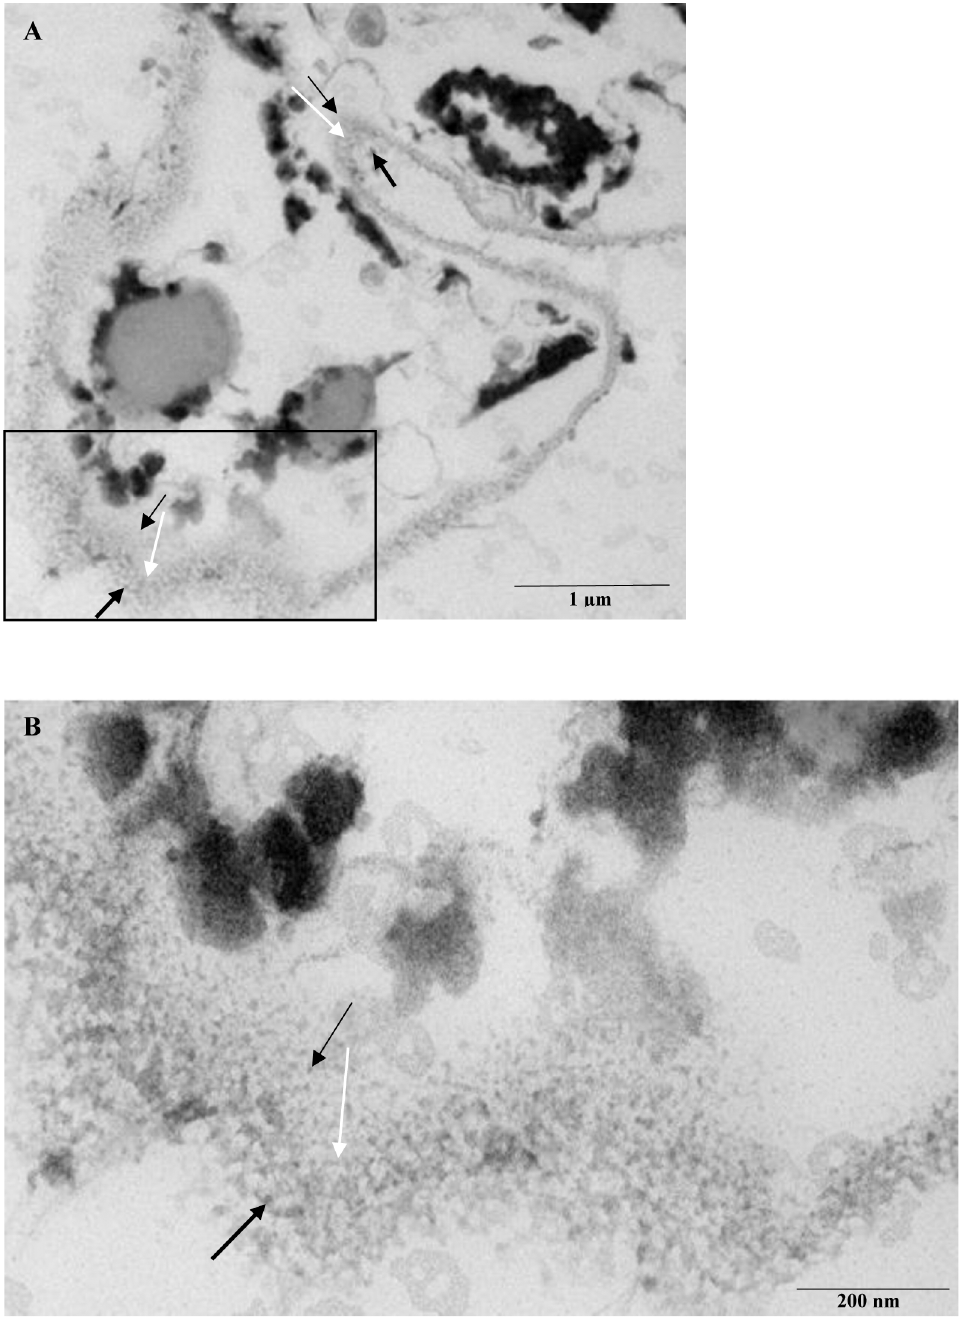
Fig 4. HRTEM photomicrograph of a section of dead H . lixii biomass. (A) Section of the fungus showing the cell wall (white arrow), extracellular (darkest black arrow) and intracellular (lighter black arrow) nickel oxide NPs. (B) Expanded section (square in A) of the fungus showing the cell wall (white arrow), extracellular (darkest black arrow) and intracellular (lighter black arrow) nickel oxide